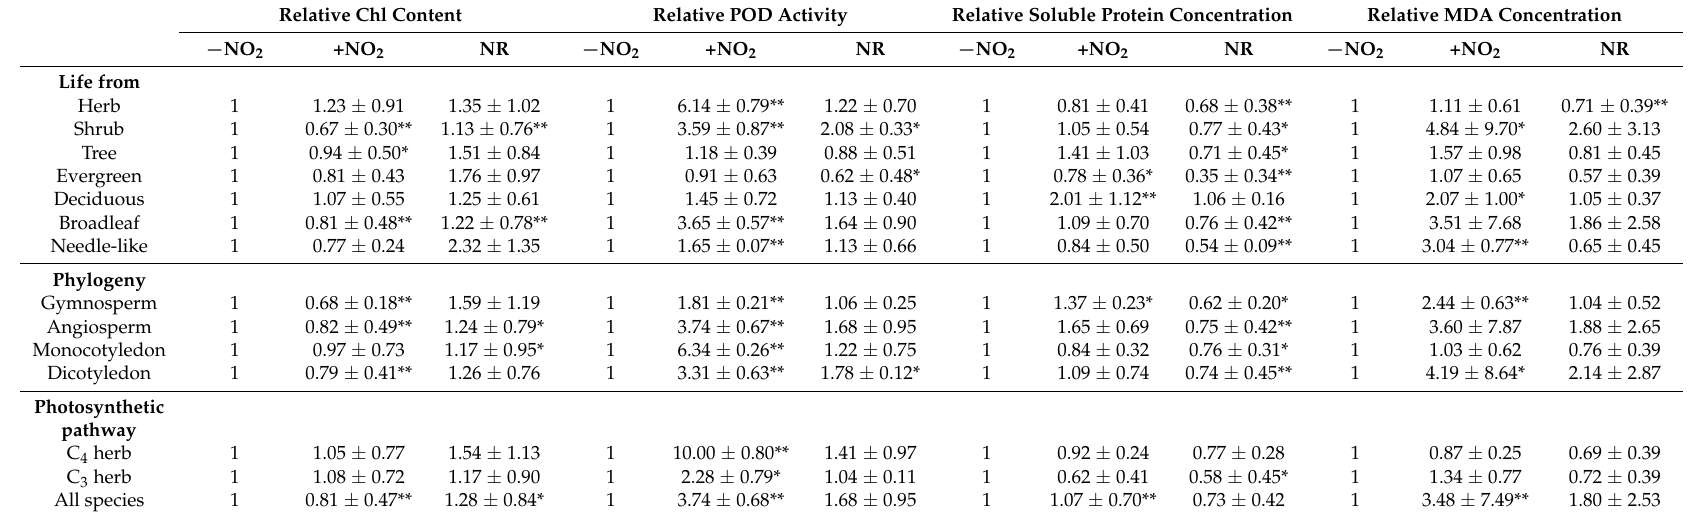
Table 3. Relative Chl content, peroxidase (POD) activity, soluble protein concentration, and malondialdehyde (MDA) concentration (folds) in different plant functional groups treated without nitrogen dioxide (NO 2 ) ( − NO 2 ), with 72 h NO 2 stress (+NO 2 ) or after 30 d of natural recovery